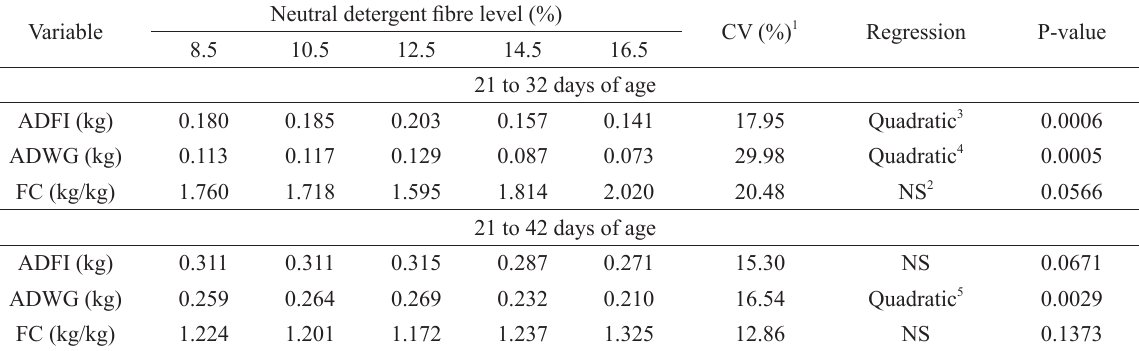
Average daily feed intake (ADFI), average daily weight gain (ADWG), and feed conversion (FC) of piglets fed different levels of neutral detergent